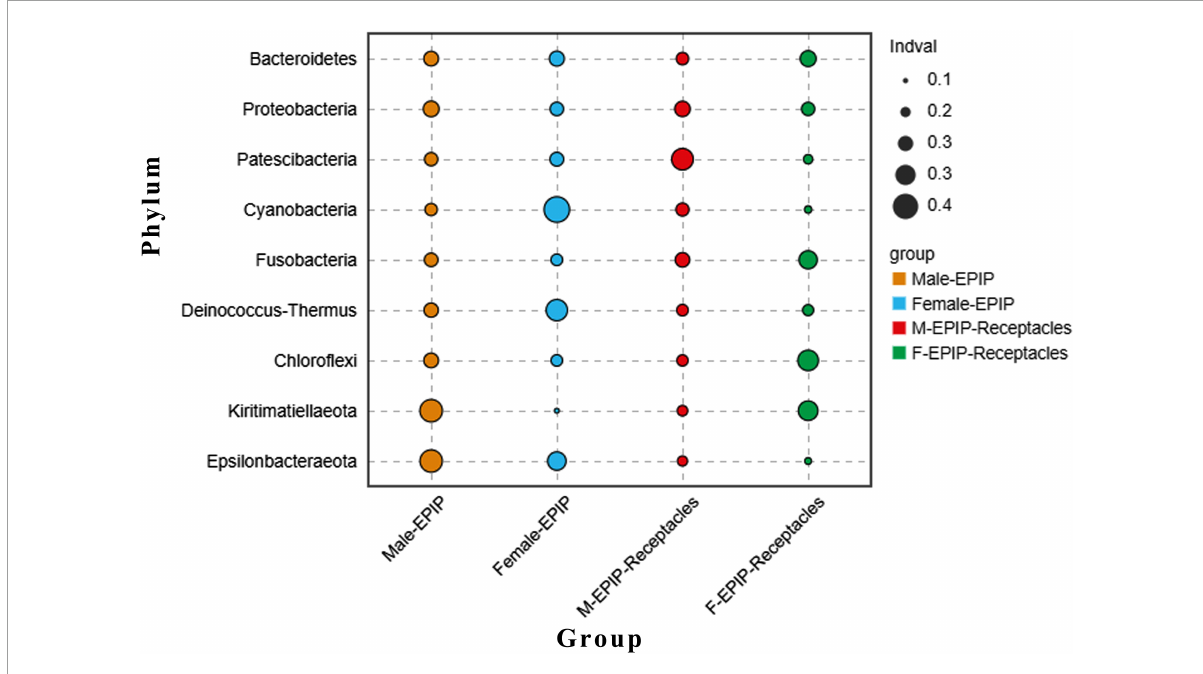
FIGURE6 Indicator analysis of epiphytic bacteria of algal bodies and receptacles of male and female S. thunbergii at the phylum level.